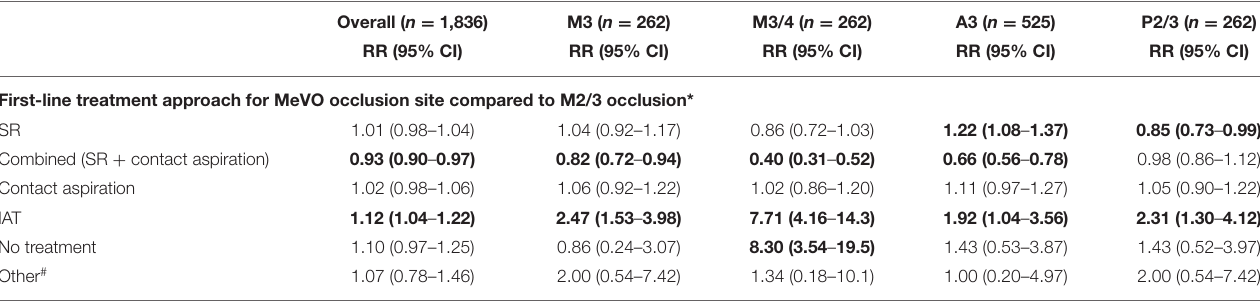
TABLE 1 | Likelihood of preferred first-line approach (stent-retriever, combined stent-retriever and aspiration, aspiration, intra-arterial thrombolysis, or other) per occlusion site (reference: M2/3). Overall ( n =